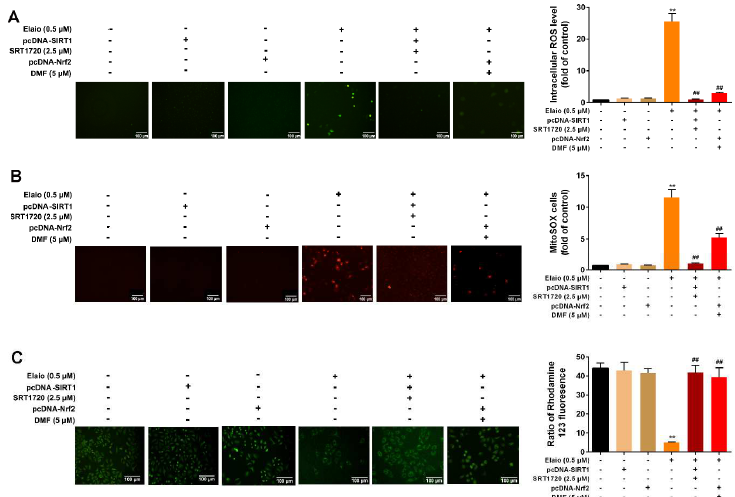
Figure 7. Activation of SIRT1/Nrf2 signaling attenuates the antioxidant effect of elaiophylin in A549 cells. The cells were divided into six groups: control, SIRT1 overexpression only, Nrf2 overexpres- sion only, elaiophylin, elaiophylin+SIRT1 activation (SIRT1 overexpression plus SRT1720), elaiophylin+Nrf2 activation (Nrf2 overexpression plus DMF). ( A , B ) Intracellular ROS level was as- sessed using DCFH-DA fluorescence probe , and mitochondrial ROS level was evaluated using Mi- tosox Red fluorescence probe. ( C ) Mitochondrial membrane potential was assessed by rhodamine 123 staining. Data were expressed as mean ± SD of three experiments. ** p < 0.01 vs. control, ## p < 0.01 vs. elaiophylin group.